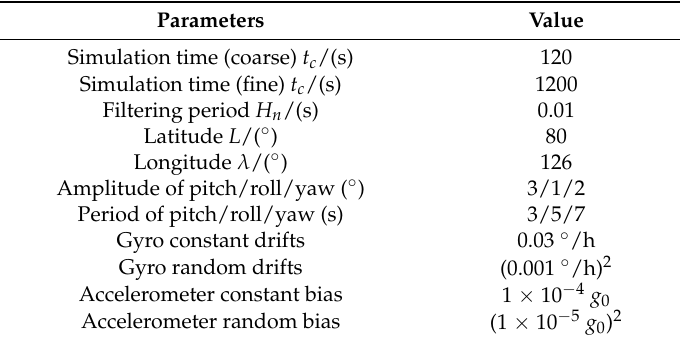
Table 1. Parameters for simulation.